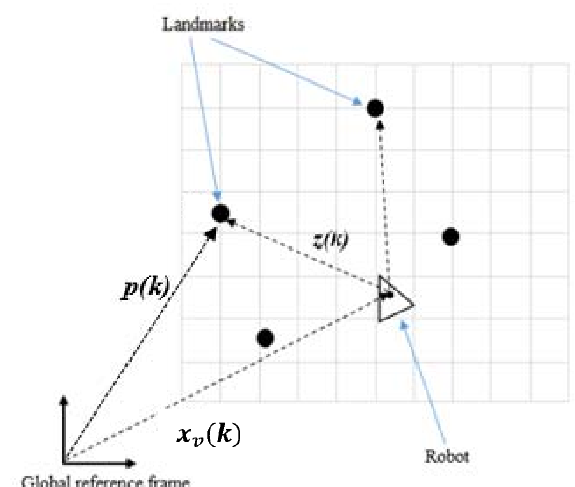
Figure 4. Gazebo simulation of Drobo.